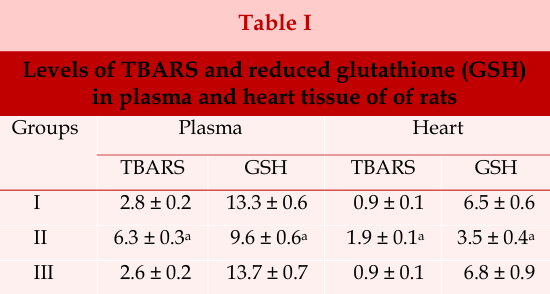
Levels of TBARS and reduced glutathione (GSH) in plasma and heart tissue of of